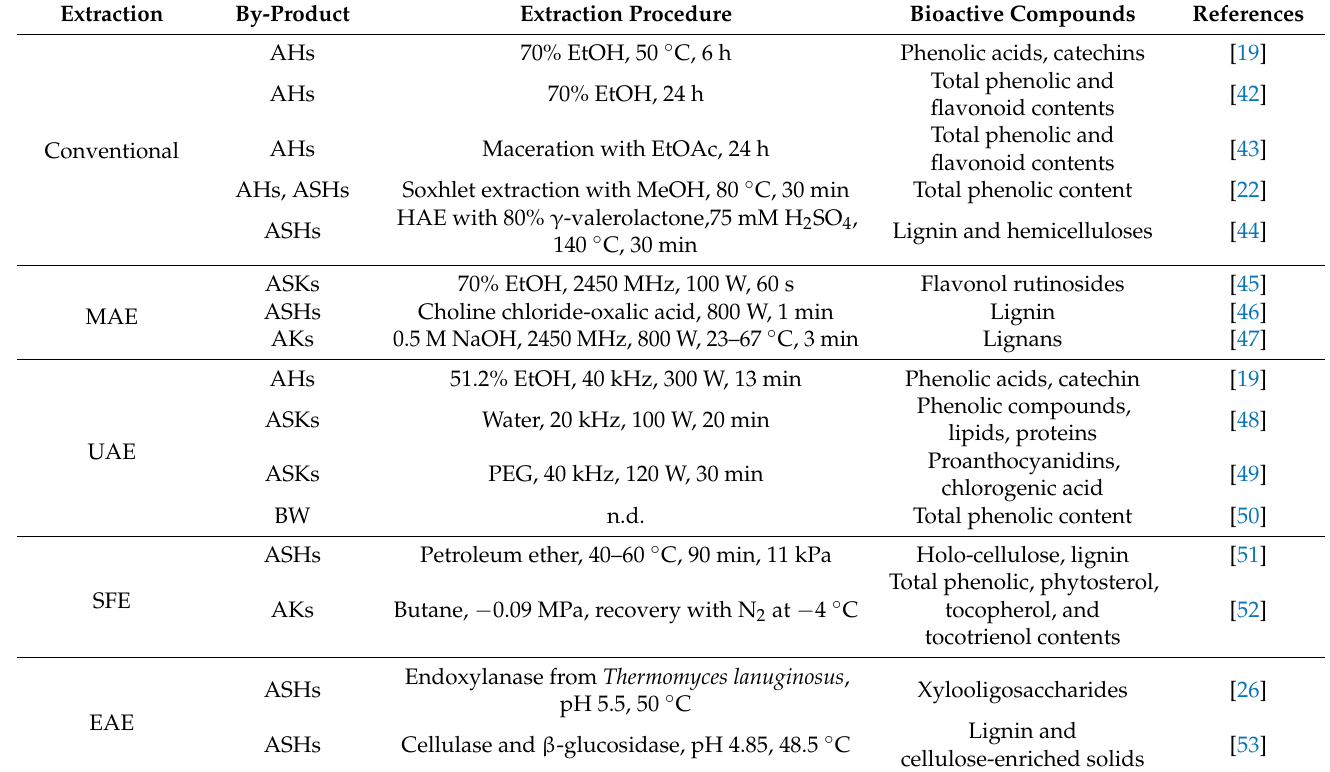
Table 1. Extraction procedures applied to almond by-products for the recovery of bioactive compounds. Extraction By-Product Extraction Procedure Bioactive